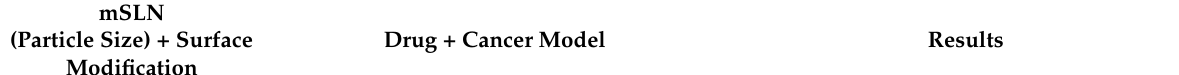
Table 5. Magnetic solid lipid nanoparticles (mSLNs) as drug delivery systems and theranostic agents against